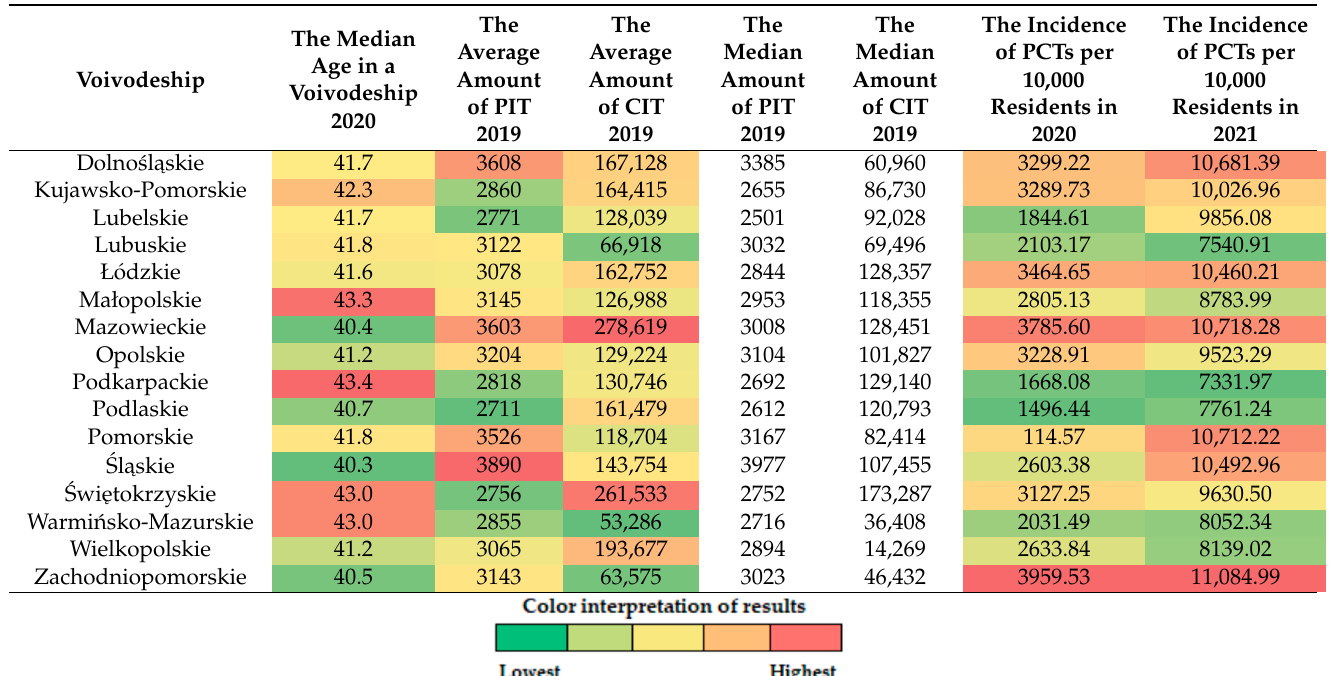
Table 3. The table presents the Pearson correlation coefficient results between the average/median PIT/CIT and the incidence of PCTs per 10,000 residents.